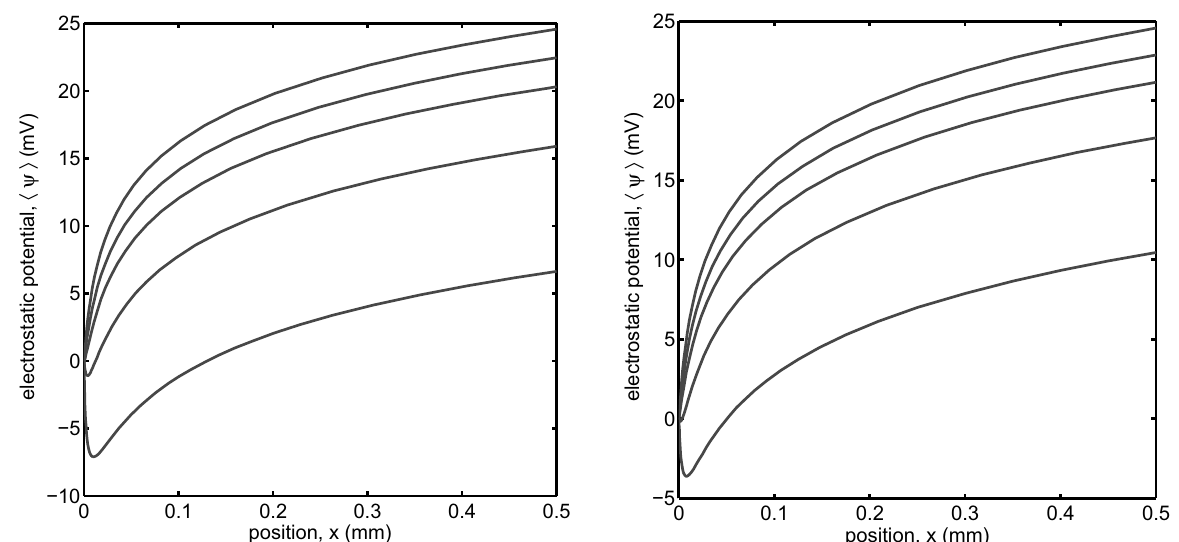
Fig. 2 – Bulk electrostatic potential h ψ i , scaled with kT / e ≈ 25 mV, as a function of position x (mm), decreasing monotonically with increasing particle volume fraction φ = φ ∗ ( 0 , 0 . 1 , 0 . 2 , 0 . 4 , 0 . 8 ) = ( 0 , 0 . 0534 , 0 . 1069 , 0 . 2137 , 0 . 4275 ) × 10 − 3 : constant bulk electrolyte concentration gradient is practically constant. See text and Tables I–III for other microscale parameters.